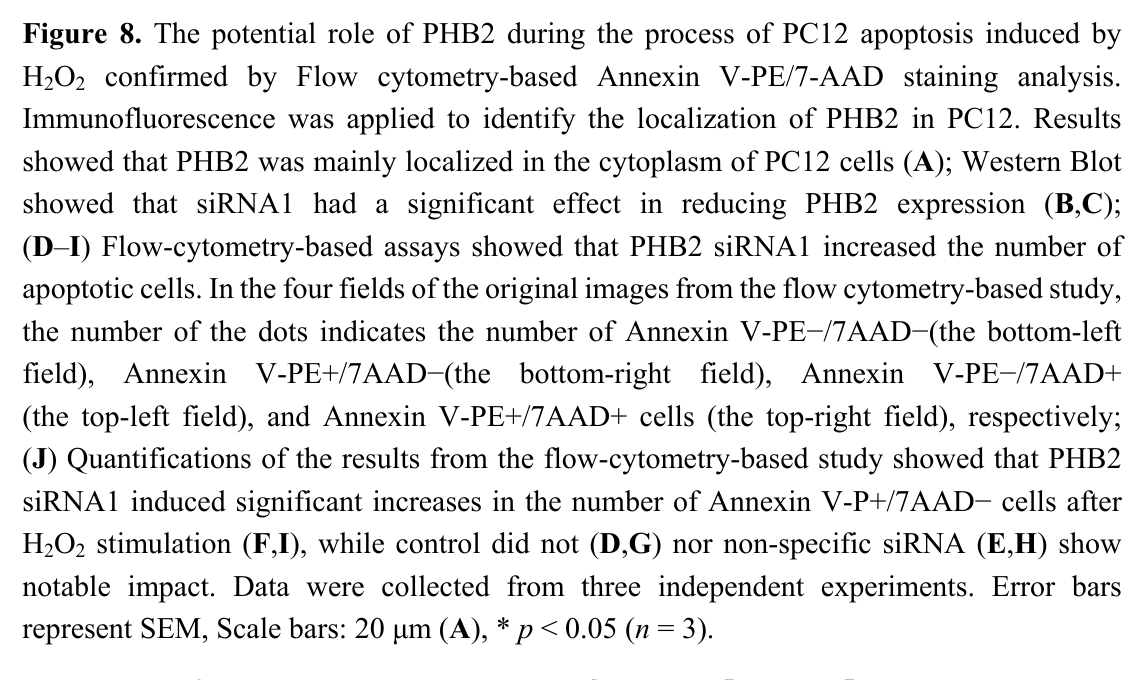
Figure 8. The potential role of PHB2 during the process of PC12 apoptosis induced by H O confirmed by Flow cytometry-based Annexin V-PE/7-AAD staining 2 2